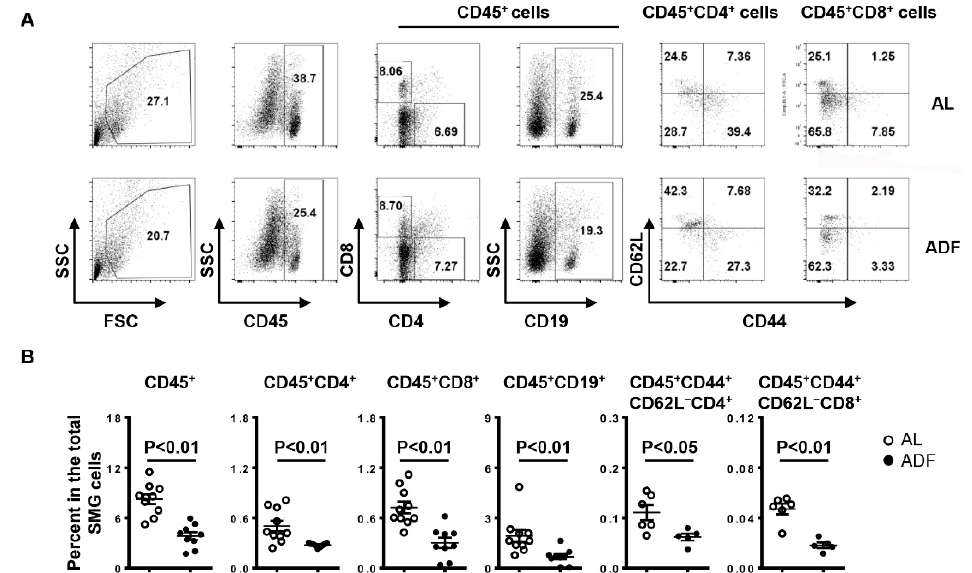
Figure 2. Alternate-day fasting (ADF) decreases T and B cell accumulation in the SMGs. 10-week-old female NOD mice were deprived of food every other day or fed with standard chow ad libitum ( AL ) for 3 weeks. ( A ) Flow cytometry profile of lymphocyte populations in the SMG cells. ( B ) The average percentage of lymphocyte subpopulations among the SMG cells. Data are representative or the average of at least 5–6 mice each group, with majority of the data generated from 7–10 mice each group.